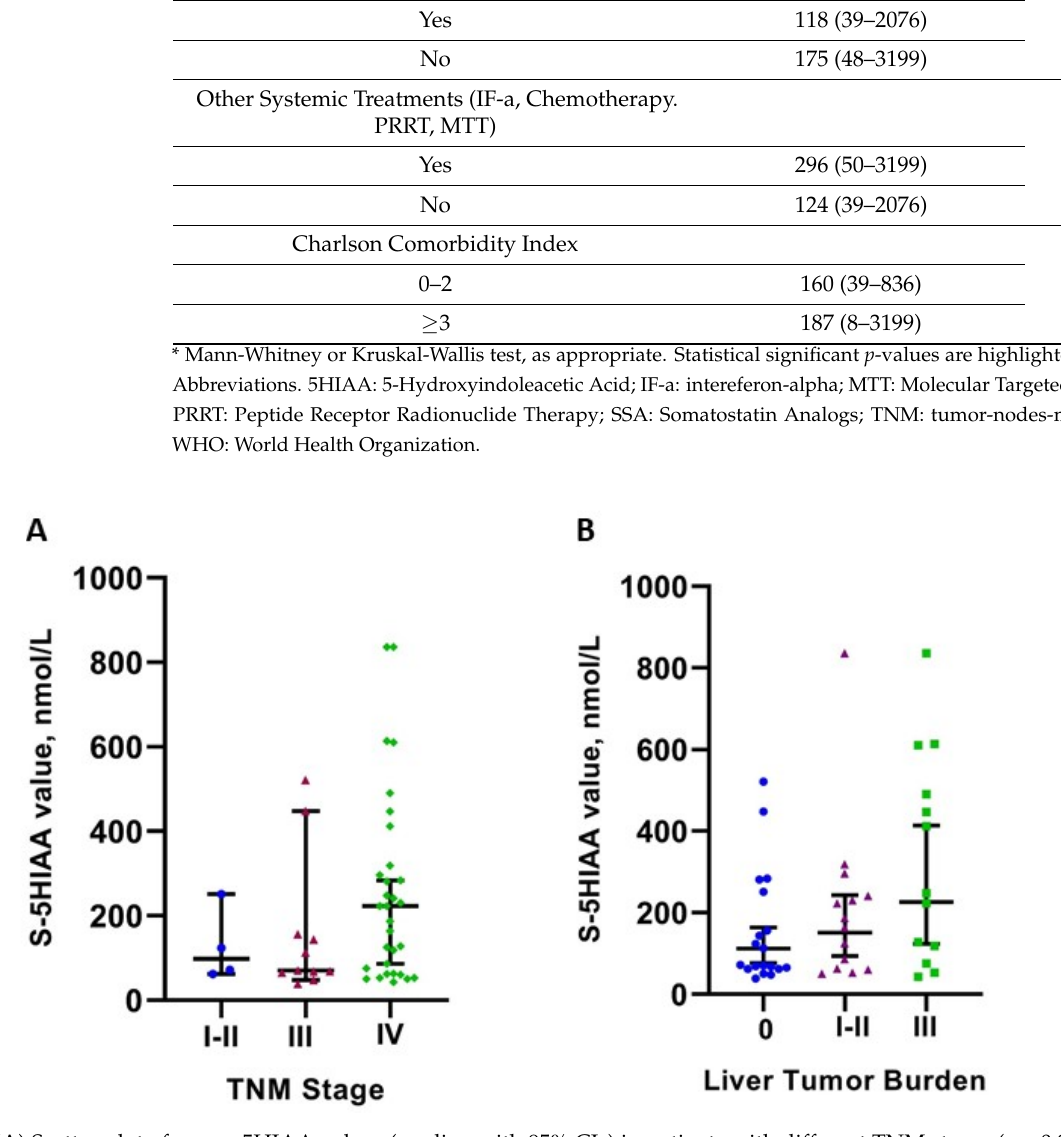
Figure 2. ( A ) Scatter plot of serum 5HIAA values (median with 95% CIs) in patients with different TNM stages ( p = 0.398). Only four patients in the study cohort exhibited TNM stages I and II at the time of serum 5HIAA sampling. ( A ) Scatter plot of serum 5HIAA values (median with 95% CIs) in patients with different types of liver involvement ( p = 0.041). Only two patients exhibited bilobar and/or 5–10 liver metastases at the time of serum 5HIAA measurement; hence types I and II in ( B ) were grouped together. Two outliers are not presented in ( A , B ) because their data points were outside the range of the y axis. The excluded values were: 3199 and 2076 nmol/L; both cases had TNM stage IV disease and extensive (type III) liver